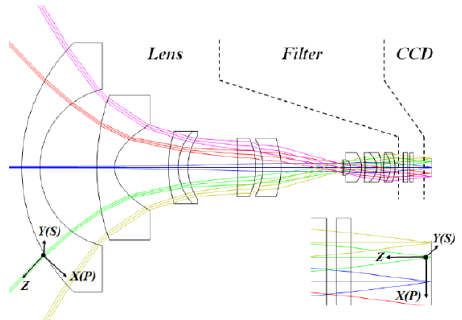
Figure 1. Layout of the SDPC optical structure Due to the oblique incidence, the ultra-wide-angle telecentric optical lenses produce polarization sensitivity. The polarization sensitivity changes the polarization states of incident beams which significantly impact the polarimetric calibration accuracy. Previous experimental results (Che et al., 2009; Li et al., 2007; Sun et al., 2010; Wang et al., 2014) indicate that the maximum transmission direction of ultra-wide-angle telecentric optical lenses is in the meridional plane, which formed by chief ray and optical axis. The chief ray is defined as the light that passes through the center of the aperture stop from the off-axis point. Correspondingly, the minimum transmission direction is in the sagittal plane, which is perpendicular to the maximum transmission direction. As shown in Fig. 2, the maximum transmission direction is determined by the projection of meridional plane on the plane where polarizers located.